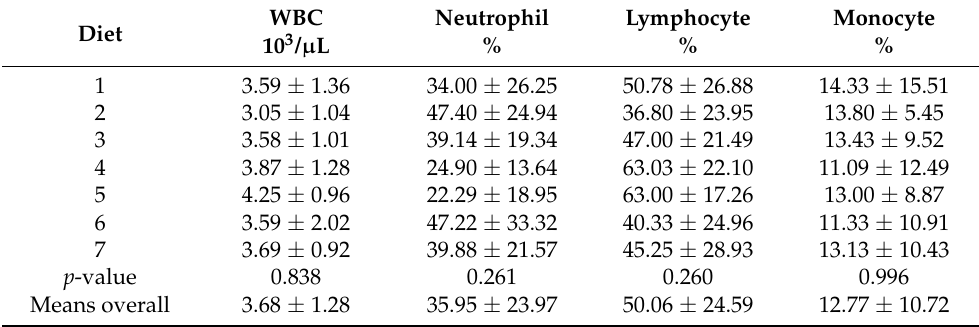
Table 7. White blood cell count WBC differential after 12 weeks of feeding with control (0% BSFLM and 100% FM), and FM replaced at 10%, 20%, 40%, 60%, 80%, and 100% of the BSF.